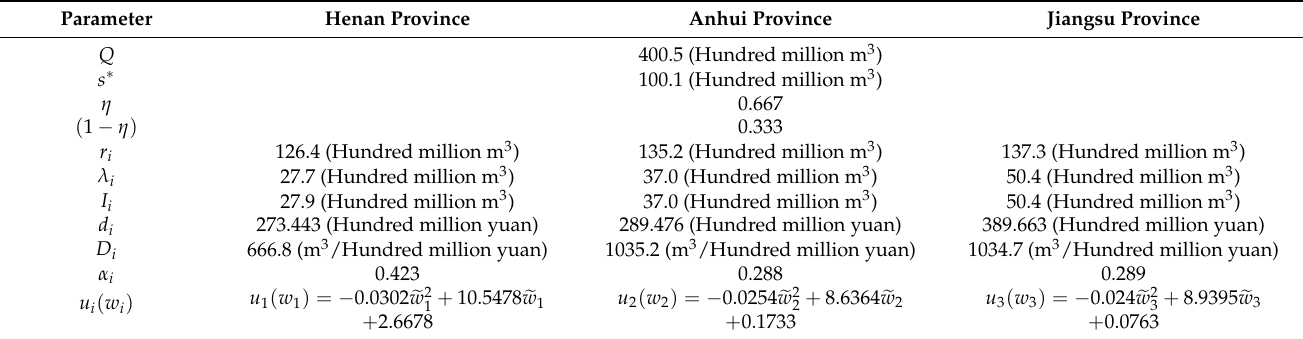
Table 1. Data required for two transboundary water resources allocation